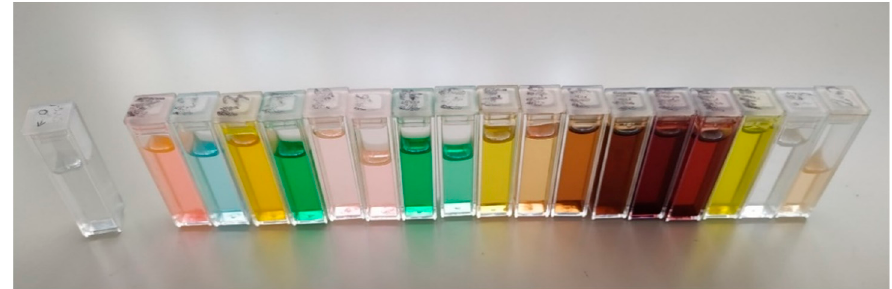
Figure 1. View of the 21 samples used in the present analysis.